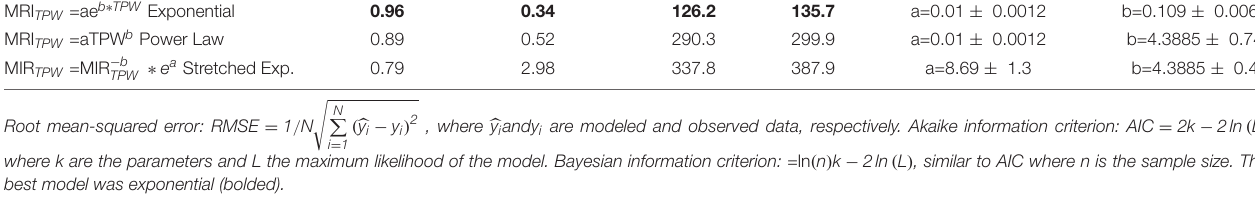
TABLE 2 | Performance measures of model selection between MRI TPW and TPW: Multiple R-squared error R 2 = ρ 2 where ρ is the correlation coefficient. Model Units R 2 RMSE [mm/h] AIC BIC Parameters